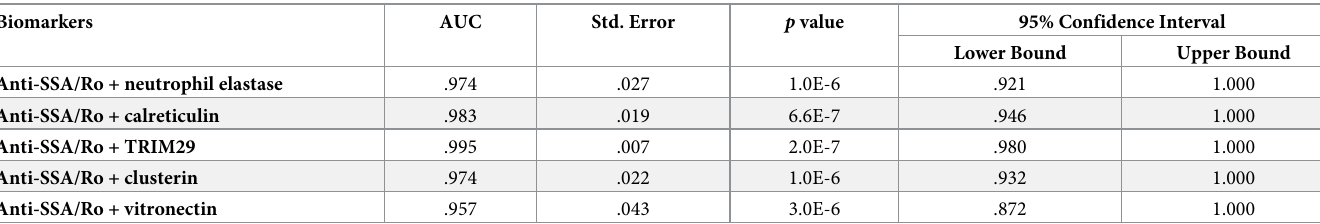
Table 4. Receiver-operating characteristic curve analysis of combined biomarkers.